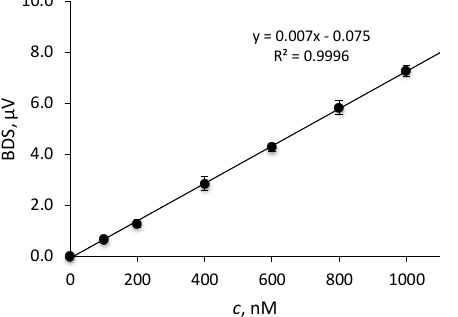
Figure 7. Calibration line for Fe(II) determination by BDS − DGT technique using a Chelex − 100 gel.